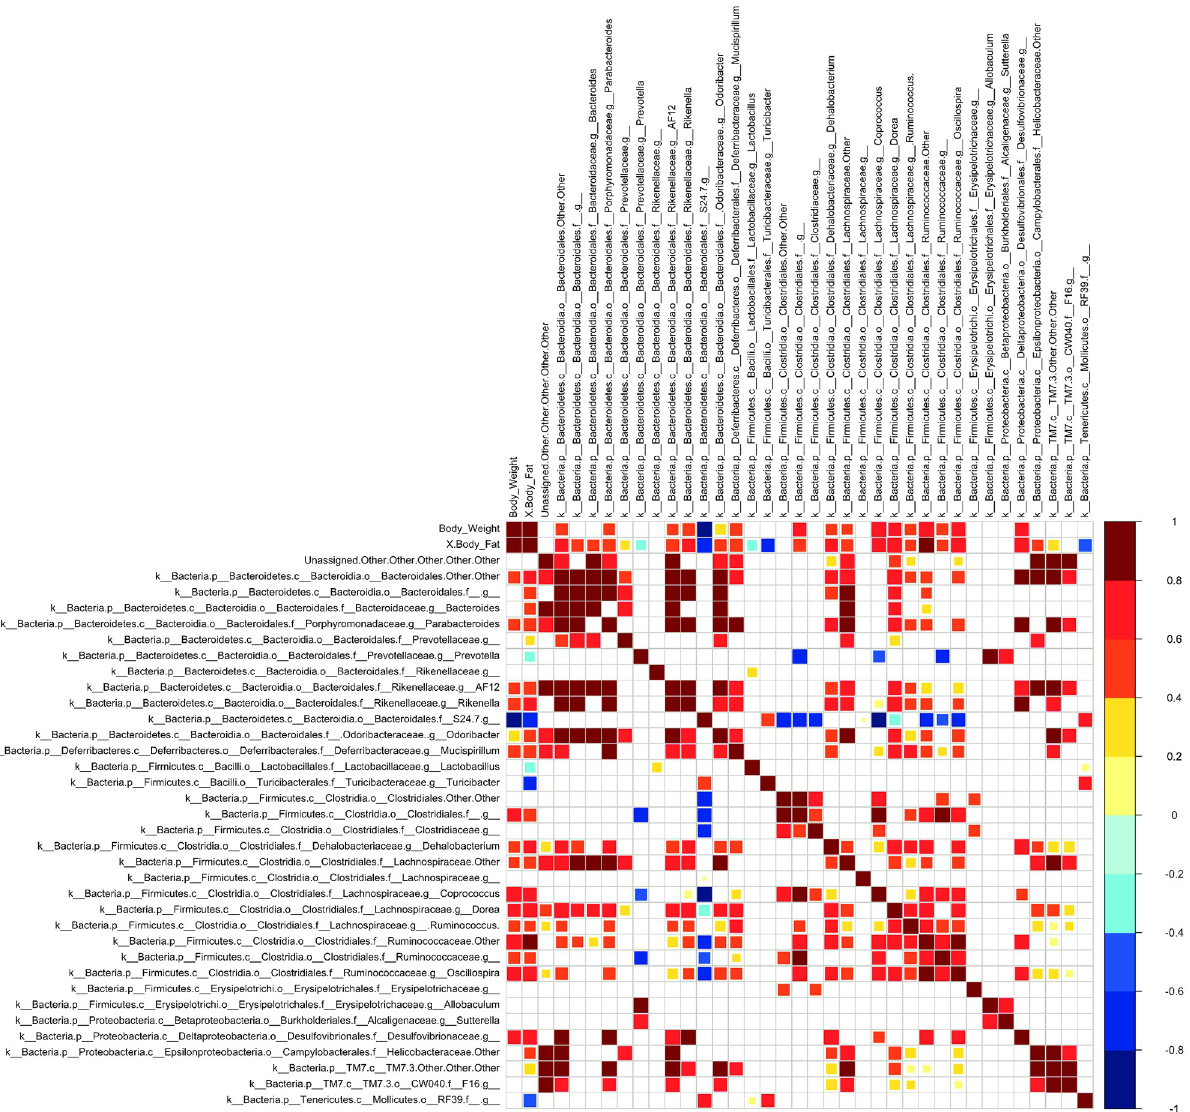
Fig 5. Metadata correlation heat map. Heat map shows Spearman rank correlations between host body weight, body fat, and relative abundances of different gut taxa from chow- and HFD-fed WT and Ogg1 -/- mice. Results are from the analysis of microbial sequences recovered from the fecal samples as described in